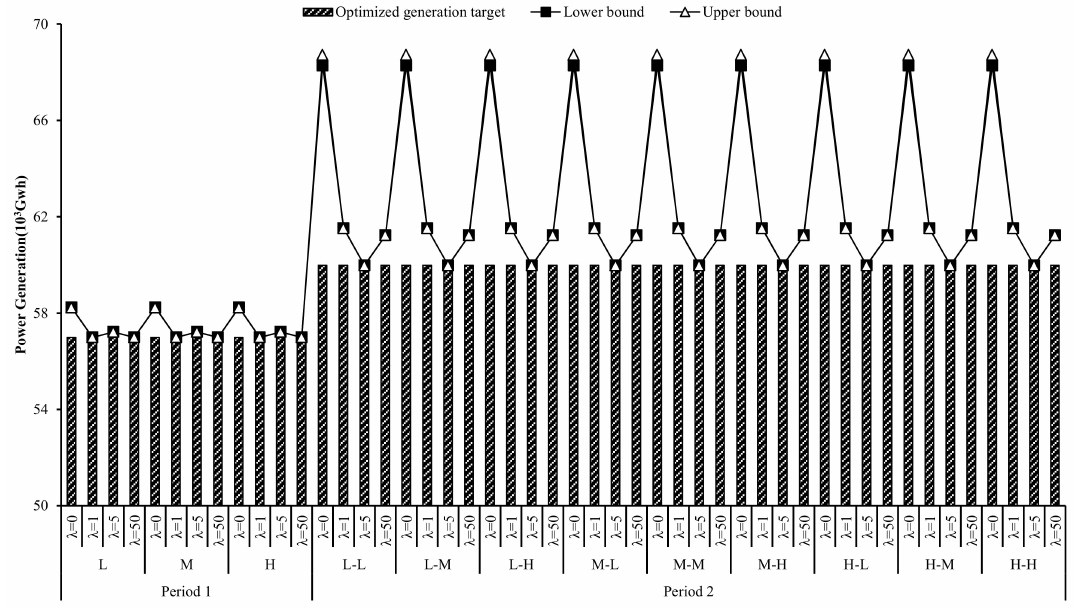
Figure 2. The optimized cogeneration operation schemes during the planning horizon.